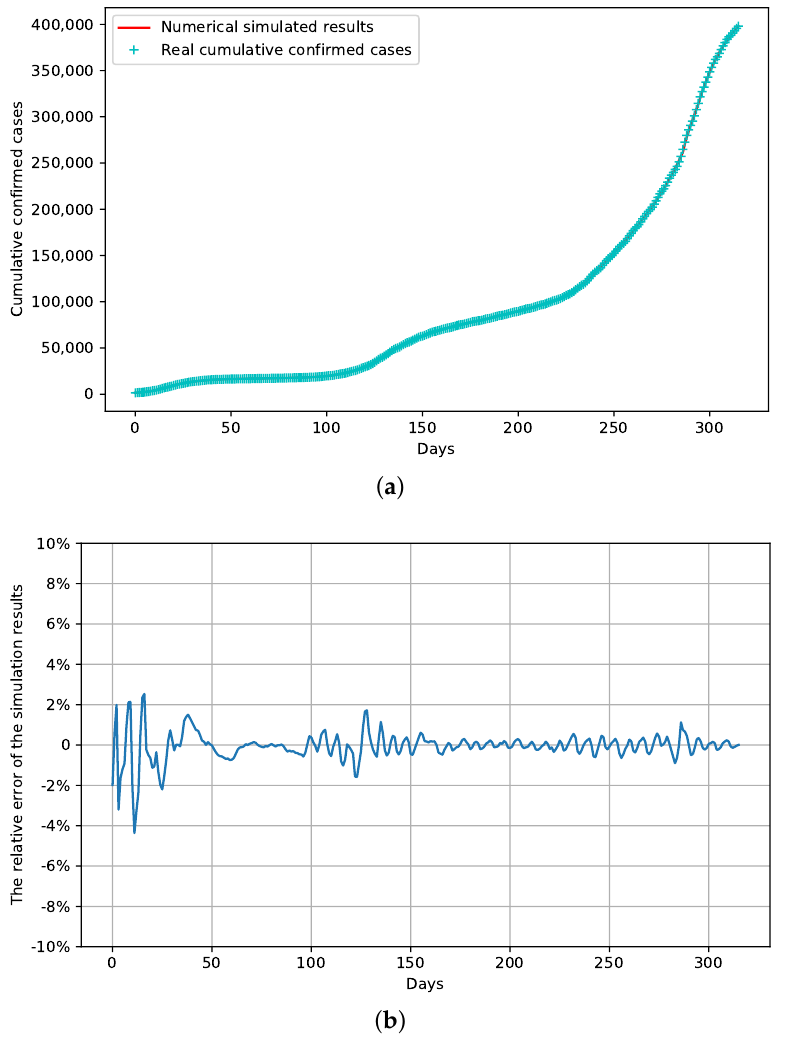
Figure 4. The simulation of confirmed cases over time by the model. ( a ) The simulated number of cases fitted well with the real accumulated confirmed cases. ( b ) The relative error between the simulated and real